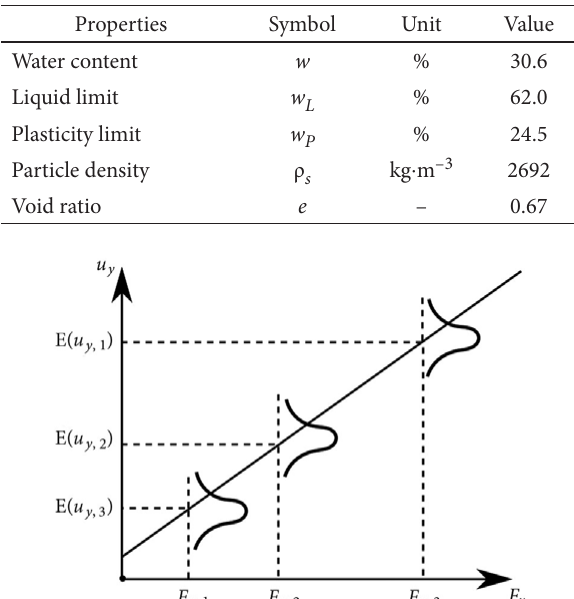
Table 2. Properties of Miocene clay